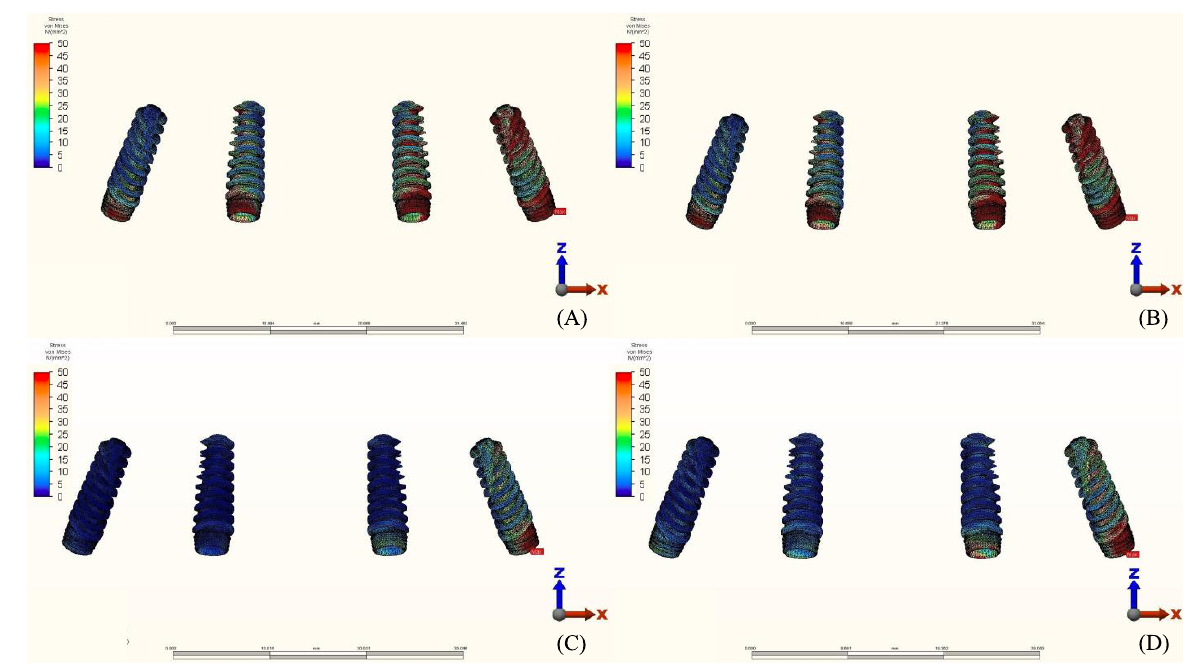
Figure 14. Implant stress distribution for group 2, titanium bar with resin composite gingiva and ceramic superstructure with zirconium (Toronto bridge). ( A ) Model 2.1, opposing natural tooth. ( B ) Model 2.2, opposing tooth-supported full ceramic crown. ( C ) Model 2.3, opposing acrylic prosthesis with titanium framework. ( D ) Model 2.4, opposing implant-supported full ceramic crown.